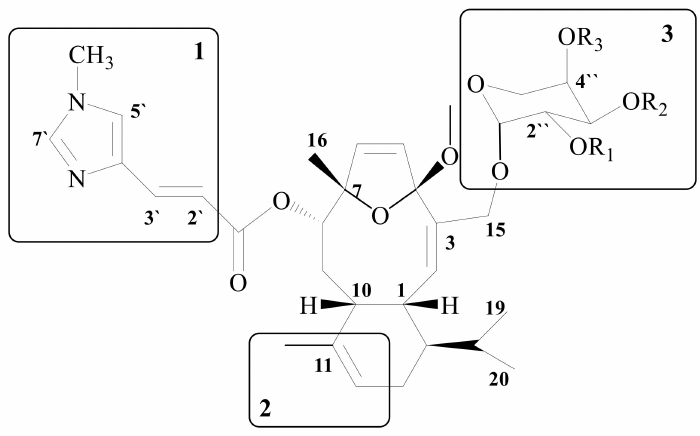
Figure 4. The three possible domains for binding to